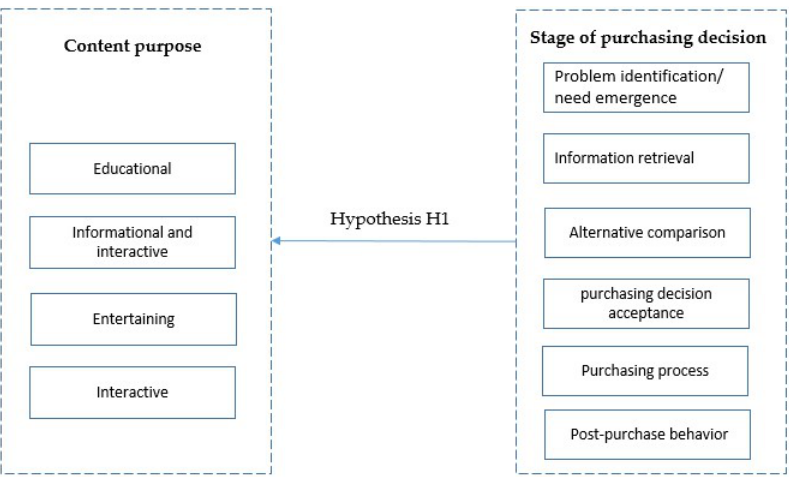
Figure 1. Factors affecting consumer choice of web content. The demographic data are presented in Table 2. The respondents consist of 21.1% males and 68.8% females. This show some limitations of results, considering that the male population is not represented in full